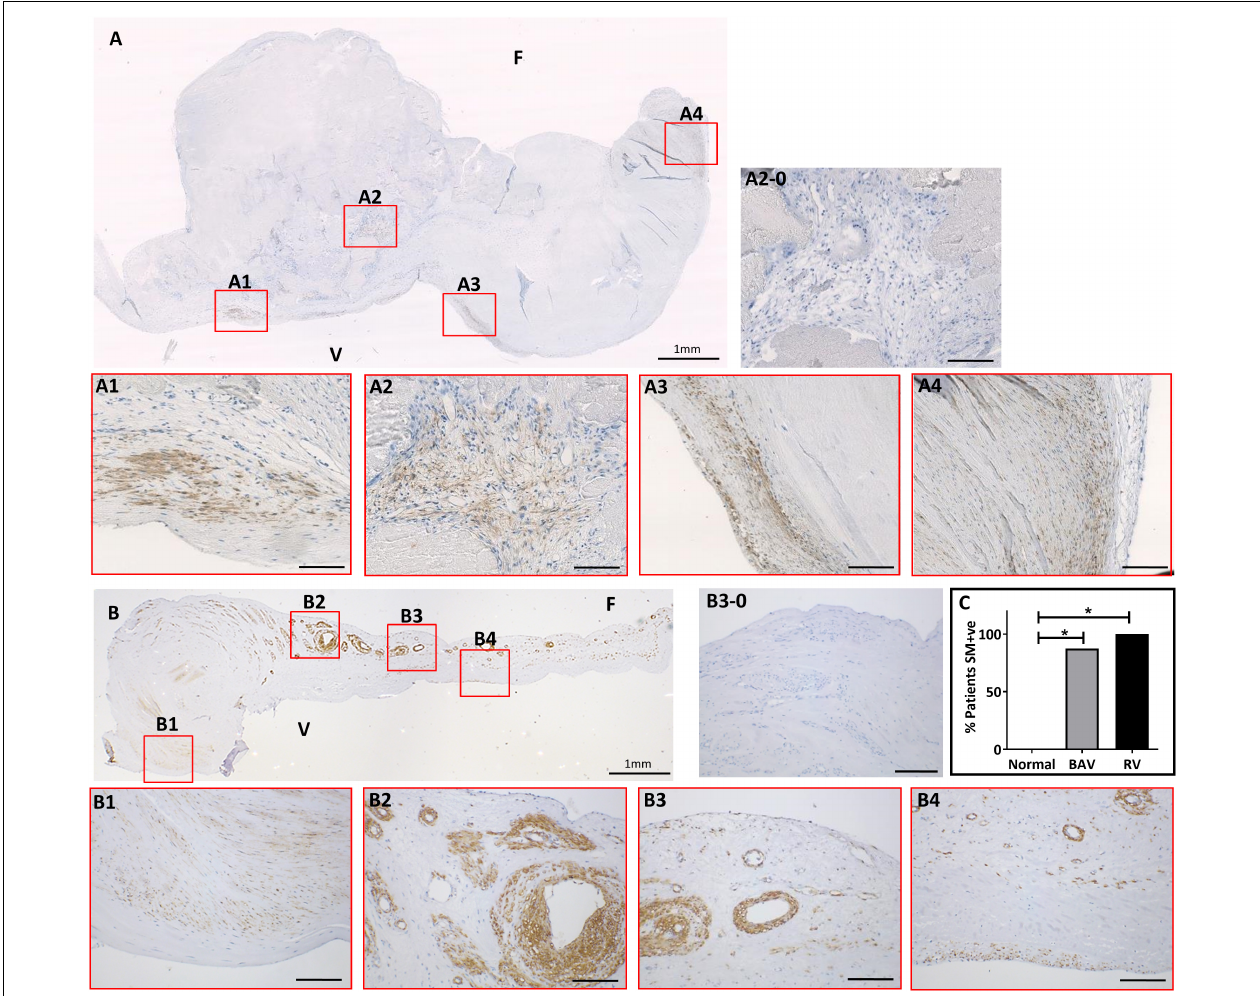
FIGURE 1 | The expression of smooth muscle (SM) markers in a bicuspid aortic valve (BAV) (A) and a rheumatic heart valve (RHV) cusps (B) . Expanded panels in red boxes show staining patterns from consecutive sections with negative control (A2-0) , SM22 (A1) , α -SMA (A2) , calponin (A3) , and SM-myosin (A4) . Expanded panels in red boxes show staining patterns from consecutive sections of B with negative control (B3-0) , SM22 (B1) , α -SMA (B2) , calponin (B3) , and SM-myosin (A4) . Panel (C) shows graph showing the incidence of aberrant SM +ve staining in BAV and RHV cusps. F and V represent fibrosal and ventricularis side, respectively. Scale bar in expanded panels represents 200 µ m. * p <